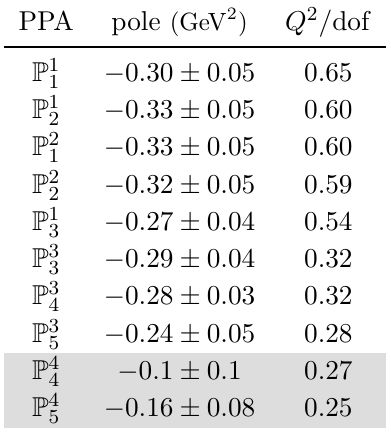
Table 4 . Location of the pole, on the negative real axis of p 2 , from the partial Padé approximants — used as fitting functions to the Landau-gauge ghost-propagator lattice data — together with the corresponding Q 2 / dof value. Results from P 4 their large